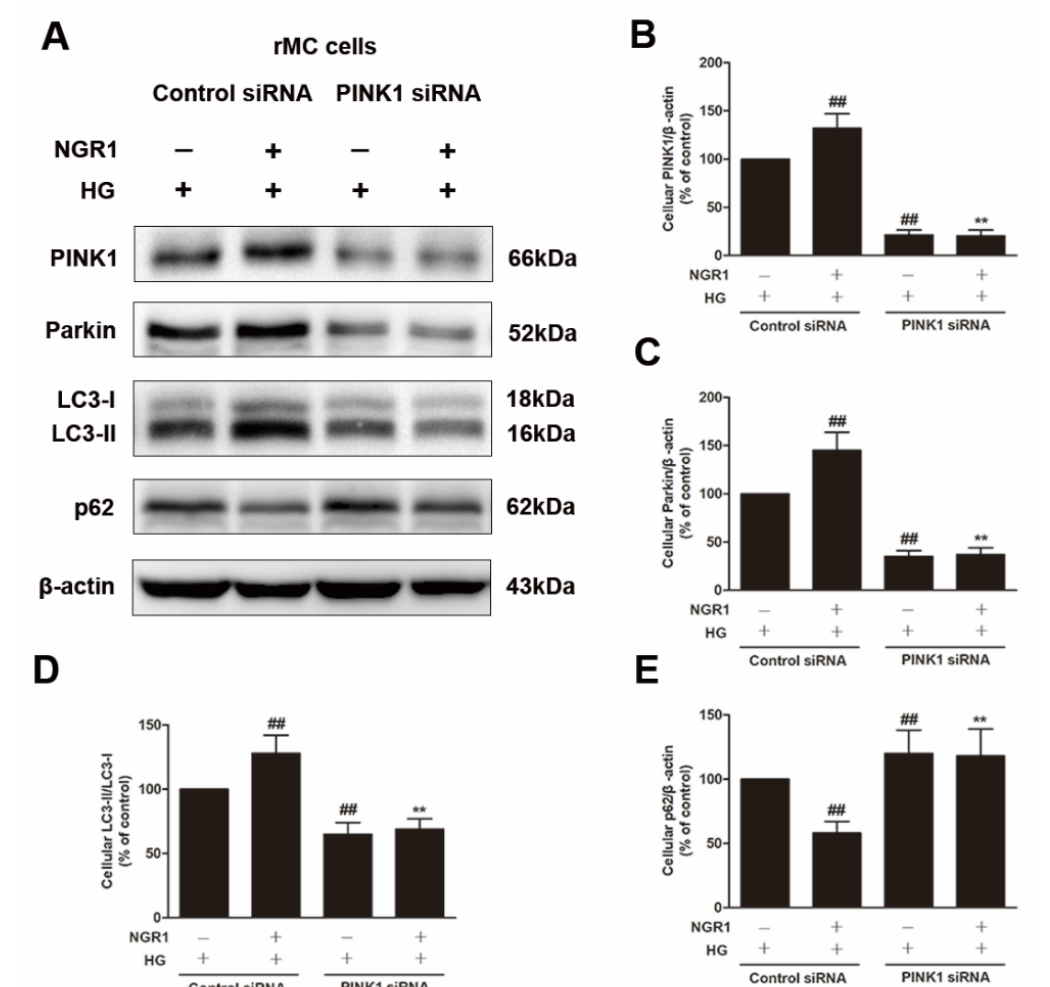
Figure 10. NGR1 enhanced mitophagy by activating PINK1. rMC cells were transiently transfected with PINK1 siRNA. ( A ) The expression of PINK1, Parkin, LC3-II/LC3-I, and p62/SQSTM1 in rMC cells was determined by Western blotting. ( B ) Quantitative densitometric analysis of PINK1 ( C ) and Parkin expression and ( D ) LC3-II/LC3-I ratio and ( E ) p62/SQSTM1 expression. The results are presented as a percentage of the control. The results are expressed as the means ± SD (n = 10). Two groups were analysed by unpaired two-tailed Student’s t tests, and multiple groups were analysed by one-way analysis of variance (ANOVA); ## indicates a significant difference from HG-treated cells transfected with control siRNA ( p < 0.01). ** indicates a significant difference from cells in the NGR1+HG group. (+), treatment with HG or NGR1; ( − ), treatment without HG or NGR1.